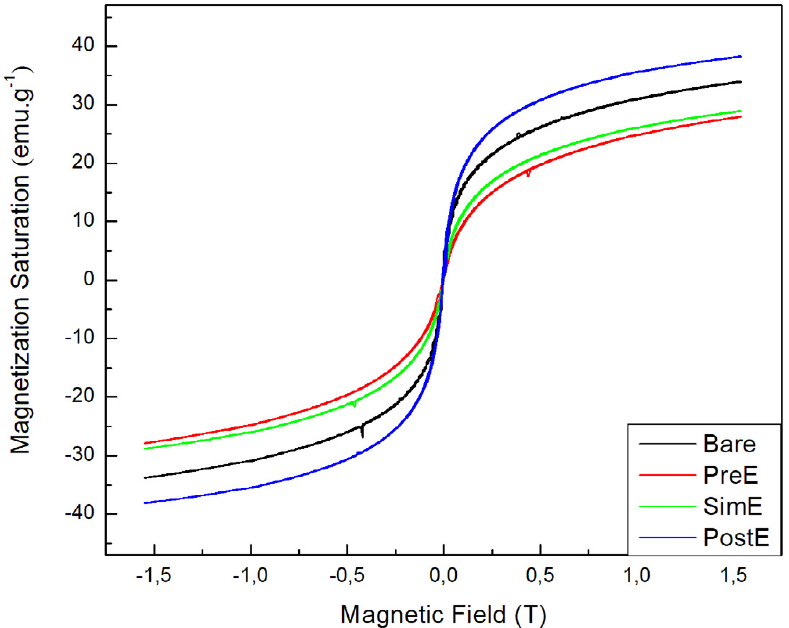
Fig. 8. M-H loops of the bare nanoparticles and the L-glutamic acid series of capped